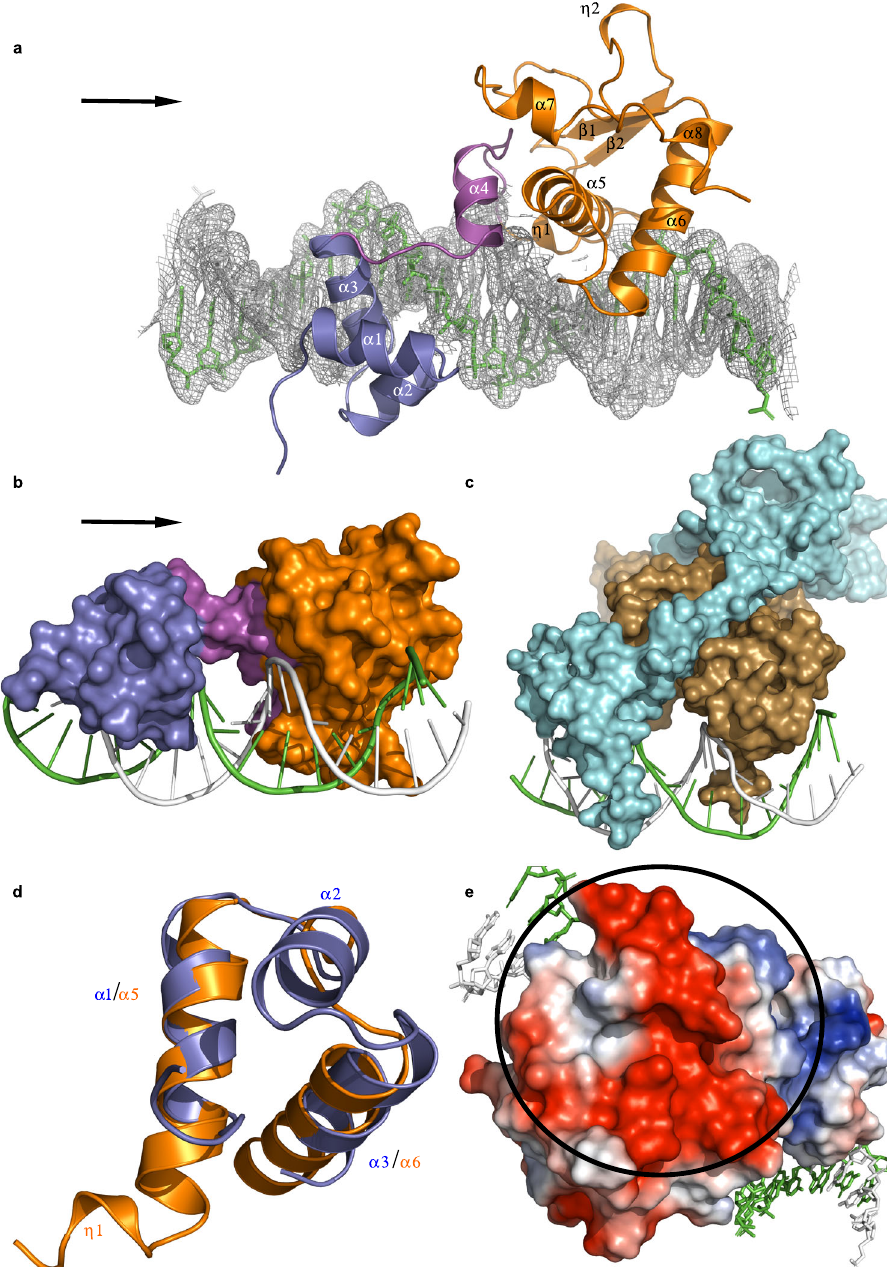
Fig. 1 Overall structure of the repressor:DNA complex. a Cartoon representation of the repressor bound to DNA. The protein monomer is colored by domain and includes the N-terminal HTH (residues 15 – 55, slate blue), the helix bridge (residues 56 – 74, magenta), and the Stoperator (residues 75 – 181, orange). The protein secondary structural elements are labeled as either alpha helices ( α ), beta strands ( β ), or 3 10 helices ( η ), and the two DNA strands are colored in green and white. 2F o – F c density, contoured at 1 sigma, is shown in gray for the DNA helix. The two DNA-binding domains engage the DNA via insertion into adjacent openings of the major groove, while the helix bridge serves as a linker between the two DNA-binding domains and lies above the minor groove. b The repressor is shown in surface view and is color-coded as in a . The arrows shown in a , b indicate the direction of transcription. c Surface view of the lambda cI dimer bound to DNA. This image was generated from coordinates 3BDN and shows the two monomers of the cI dimer colored in cyan and brown, with the two DNA strands colored in green and white. In cI, the HTH domain from each monomer of the dimer binds adjacent openings of the major groove. d Superposition of the repressor HTH (slate blue) and the DNA-binding motif of the Stoperator domain (orange). The Stoperator lacks the α 2 helix of the HTH domain and also contains a small 3 10 -helix ( η 1) at its N-terminus. e The region of the Stoperator domain that does not bind the DNA substrate is emphasized with a black circle. An electrostatic surface rendering (red: negative potential, blue: positive potential, white: neutral) reveals that this portion of the protein is acidic in nature.